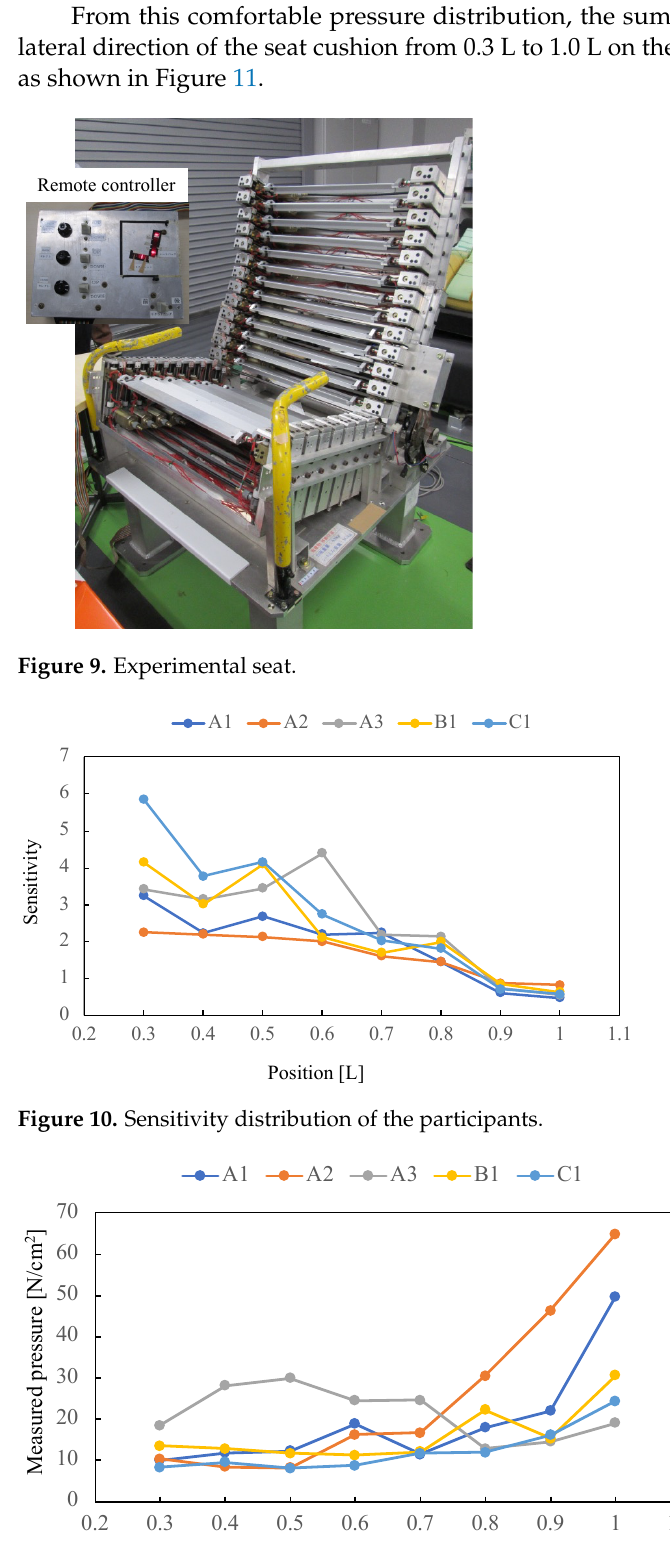
Figure 12. Perceived pressure distribution. 5. Discussion 5.1. Exponent of Power Function for Pressure Sensation The exponent of power function obtained in this study was 0.84 for the thigh and 1.11 for the buttocks. Since both are powers that should be close to 1.0, there is no significant tendency, but the thighs are sensitive to small pressure stimuli and less sensitive to large pressure stimuli. Additionally, the buttocks tended to be the opposite. Stevens investigated powers for various sensory stimuli and showed pressure on the palm for 1.1 [18]. It was suggested that there is not much difference in the body part for the pressure sensation, although the numerical values are slightly different. 5.2. Sensitivity Distribution As shown in Table 2 and Figure 8, the sensitivity distribution was less sensitive on the buttocks than on the thighs. About half of the subjects were Type A, and the thighs had almost constant sensitivity, while the remaining about half were more sensitive on